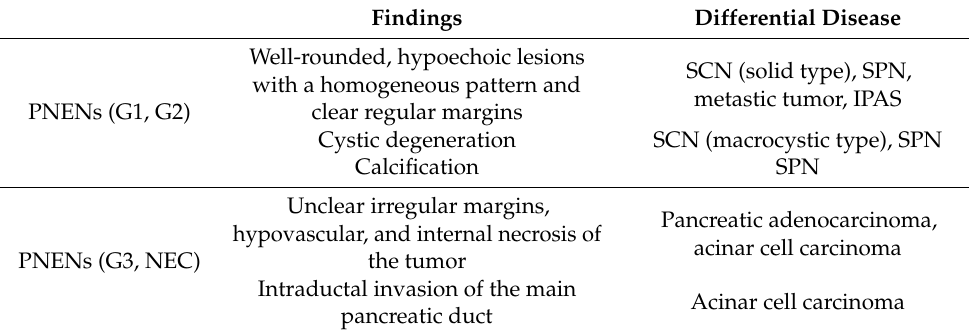
Table 1. Imaging findings and differential diseases of pancreatic neuroendocrine neoplasms (PNENs).